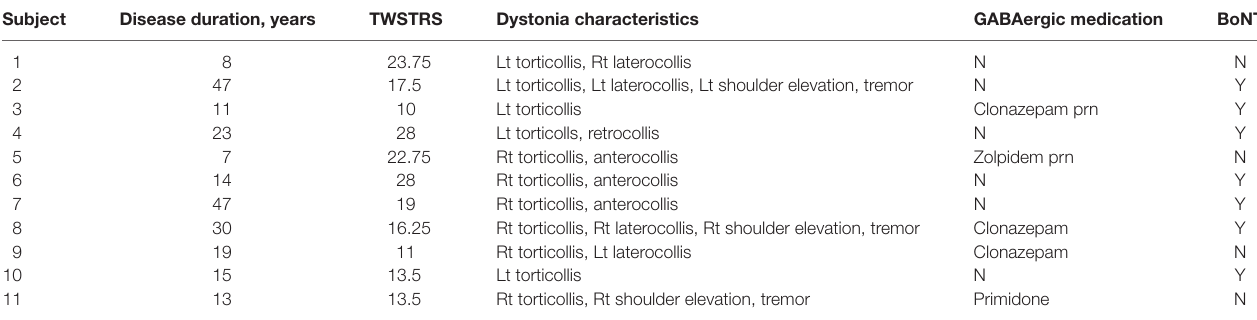
TaBle 1 | Clinical characteristics of cervical dystonia subjects included in final 11 C-flumazenil positron emission tomography (PET)